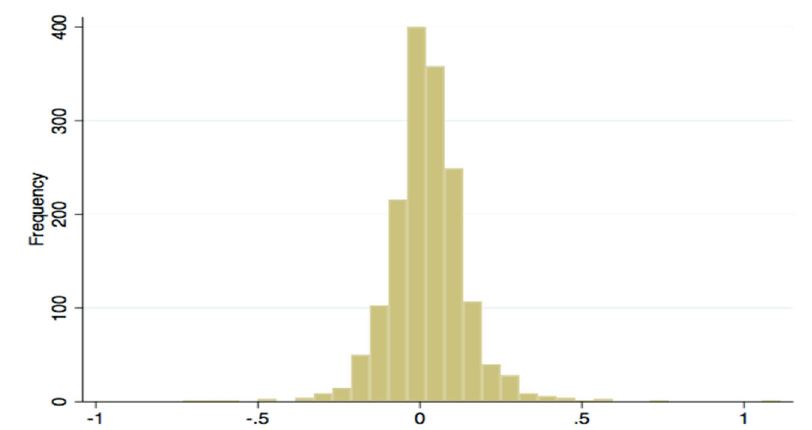
Figure 1. Histogram of changes in average executive compensation for